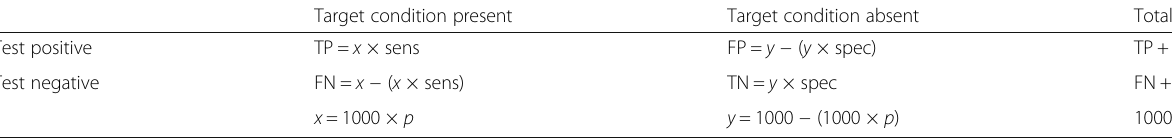
Sens sensitivity, spec specificity, p prevalence, TN true negative — test is negative and patient does not have target condition, FN false negative — test is negative but patient has target condition, TP true positive — test is positive and patient has target condition, FP false positive — test is positive but patient does not have target condition, x number of patients with target condition, y number of patients without target